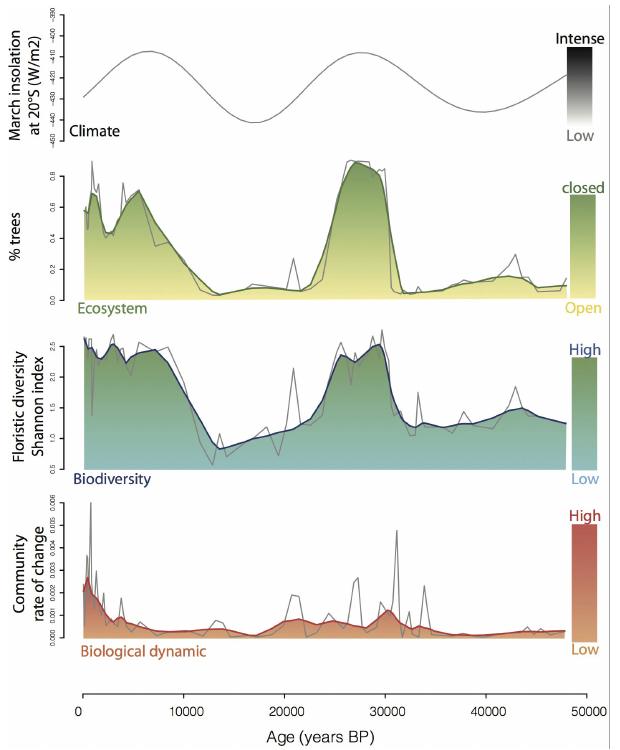
Figure 2. Synthetic diagram showing, from top to bottom, the insolation at 20 ◦ S (from Berger and Loutre, 1991), the arboreal pollen (AP) frequencies, the floristic diversity index, and the com- munity rate of change in the pollen record of Colônia during the last 50ka. The figure illustrates the relation between the forest expan- sion/regression phases and the pace of the precession signal (mod- ified by L. Bremond and C. Favier in Prospectives Ecologie Tropi- cale